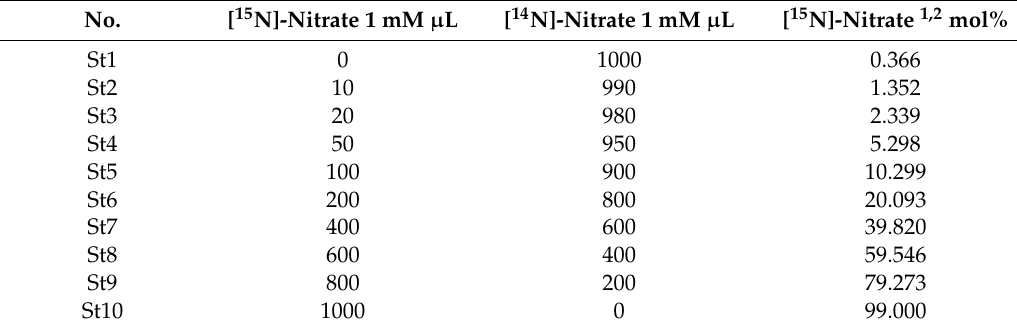
Mix the solutions indicated in Table A1 in 5 mL volumetric flasks: Table A1. Preparation of